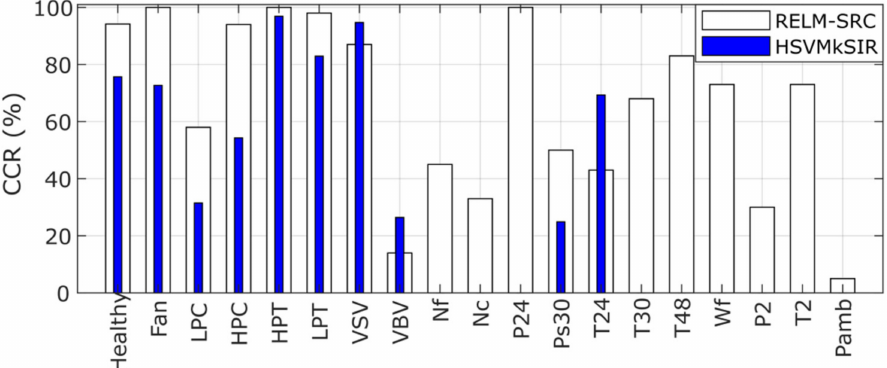
Figure 6. Correct classification rates of the proposed hybrid approach and the best technique from paper [8] for abrupt faults under cruise regime (Stage